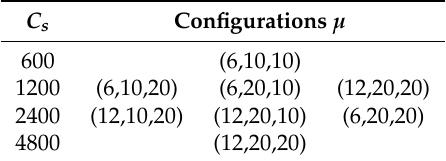
Table 3. List of the all possible configurations available with m = 6,12, a = 10,20, and d = 10,20 with the corresponding costs. C